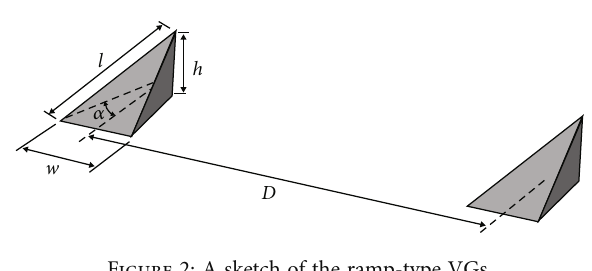
Figure 2: A sketch of the ramp-type VGs.